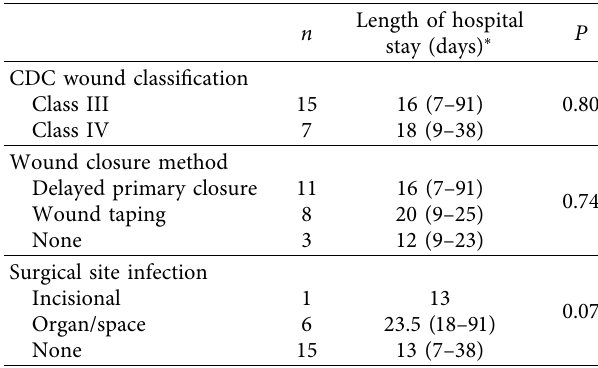
∗ Data are depicted as median (range). CDC: Centers for Disease Control and